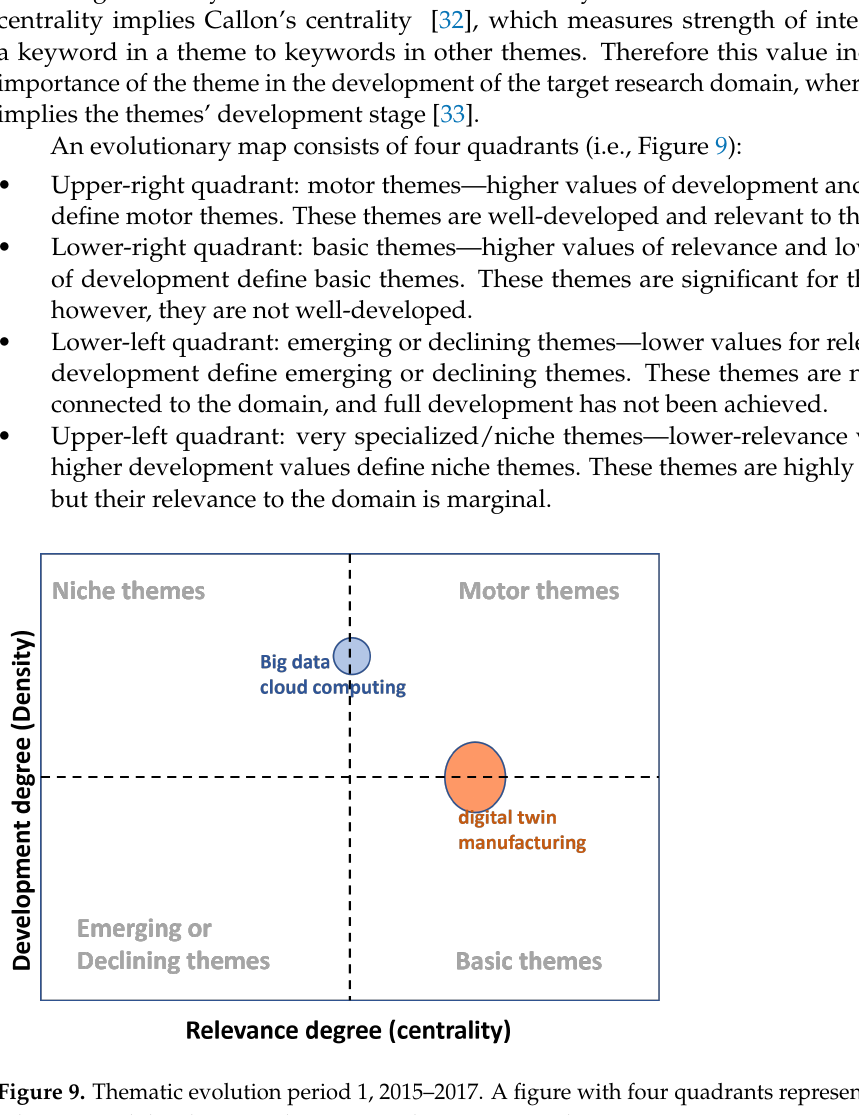
Figure 9. Thematic evolution period 1, 2015–2017. A figure with four quadrants representing specific relevance and development degree. Two themes in period 1,